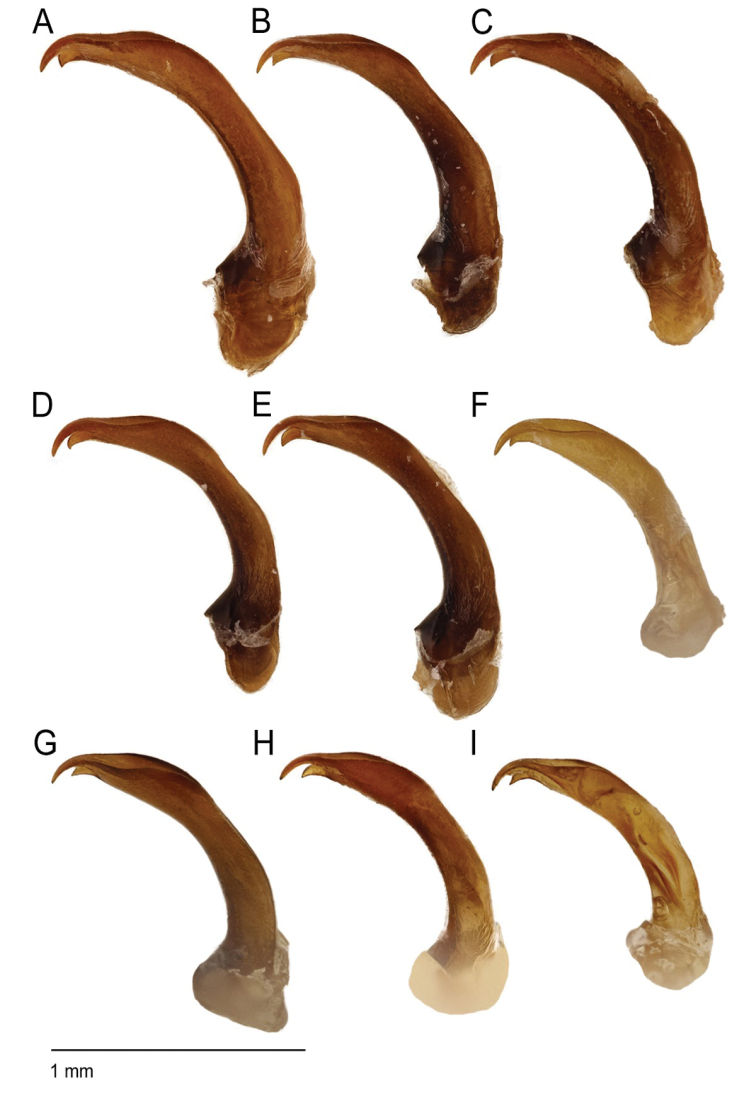
Agabus spp., aedeagus in lateral view AA.
sjostedtiBA.
dytiscoidesCA.
ruwenzoricusDA.
raffrayiEA.
pallidusFA.
anguluverpus sp. nov. GA.
austellus sp. nov. HA.
riberae sp. nov. IA.
agulhas sp. nov.